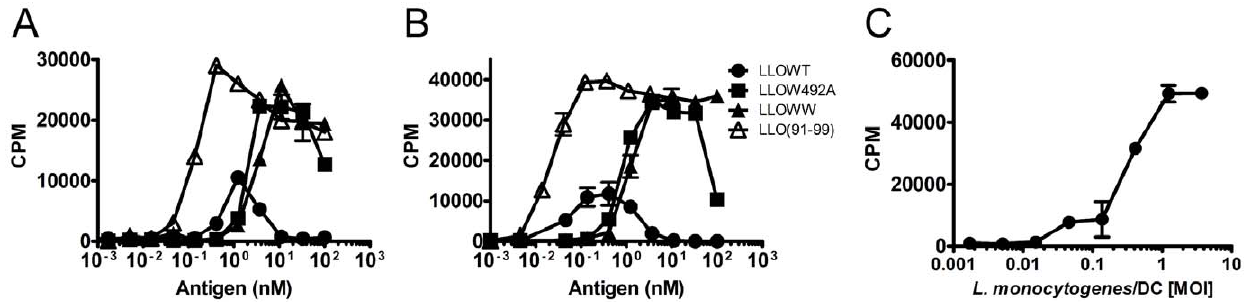
Figure 6. Antigenicity of LLO to a CD8 T cell was not dependent on cytotoxicity. A–B. H-2K d -restricted LLO(91–99)-specific hybridoma 206.15 (5 6 10 4 ) were incubated for , 16 hr. with 10 5 PEC ( A ) or 5 6 10 4 BMDC ( B ) from BALB/c mice and various concentrations of either